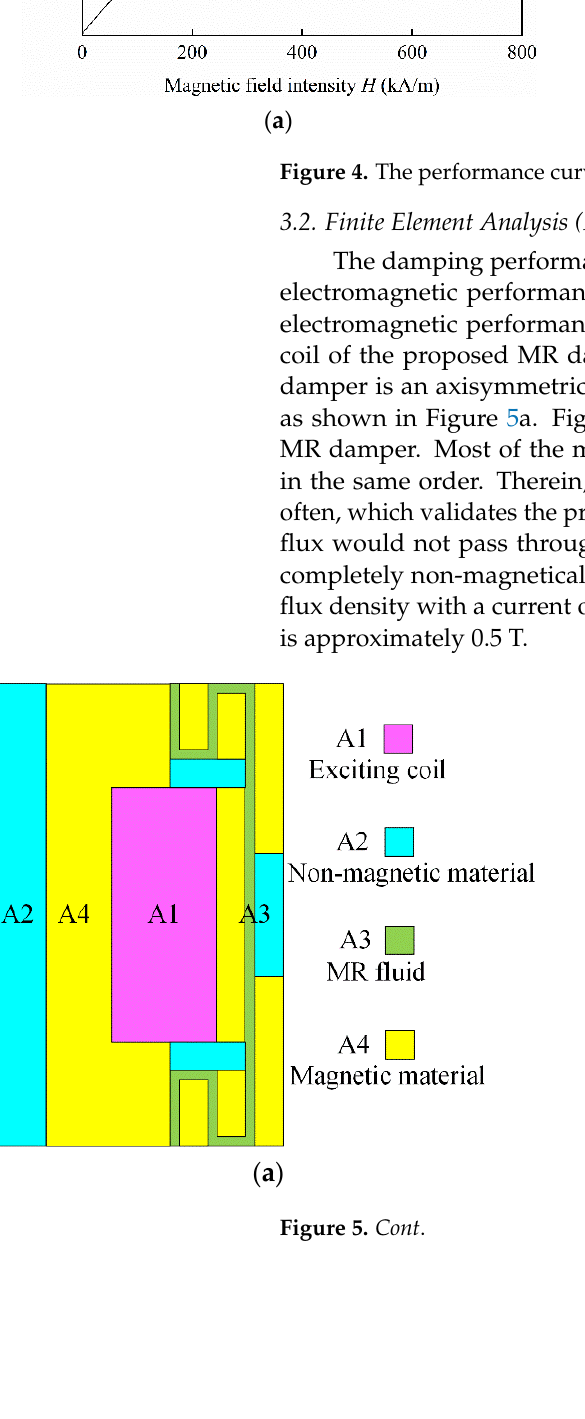
Figure 4. The performance curves of MR fluids: ( a ) B - H curve; ( b ) τ – B curve [31].